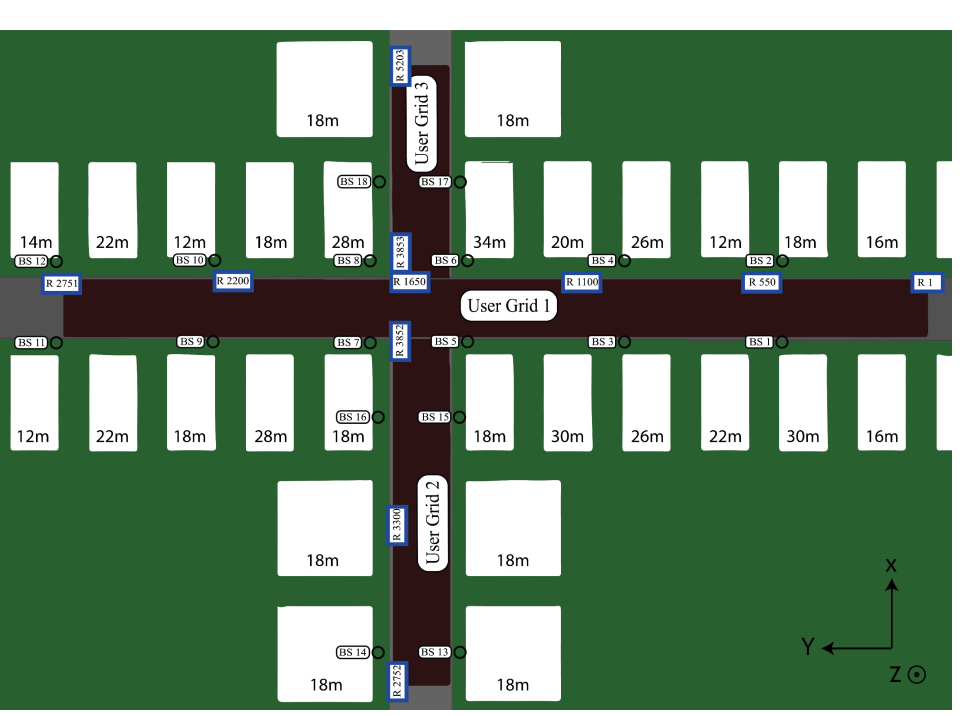
Figure 13. The O1 scenario in the DeepMIMO